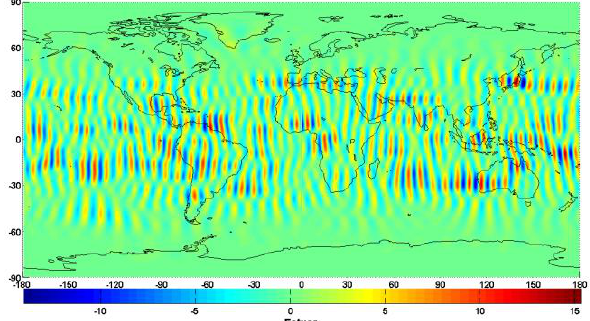
Figure 1. Eastern gravity gradient changes between the two mean gravity fields without filtering (in E unit).